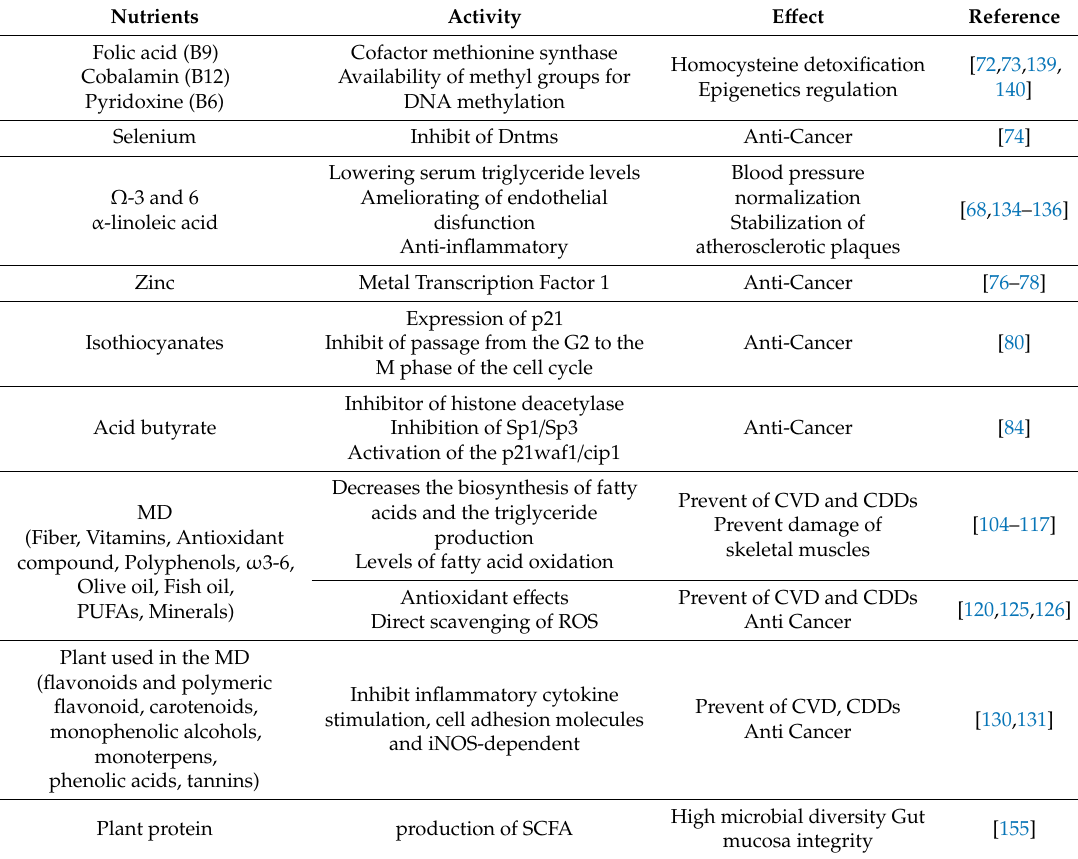
Table 2. Nutrients activity and e ff